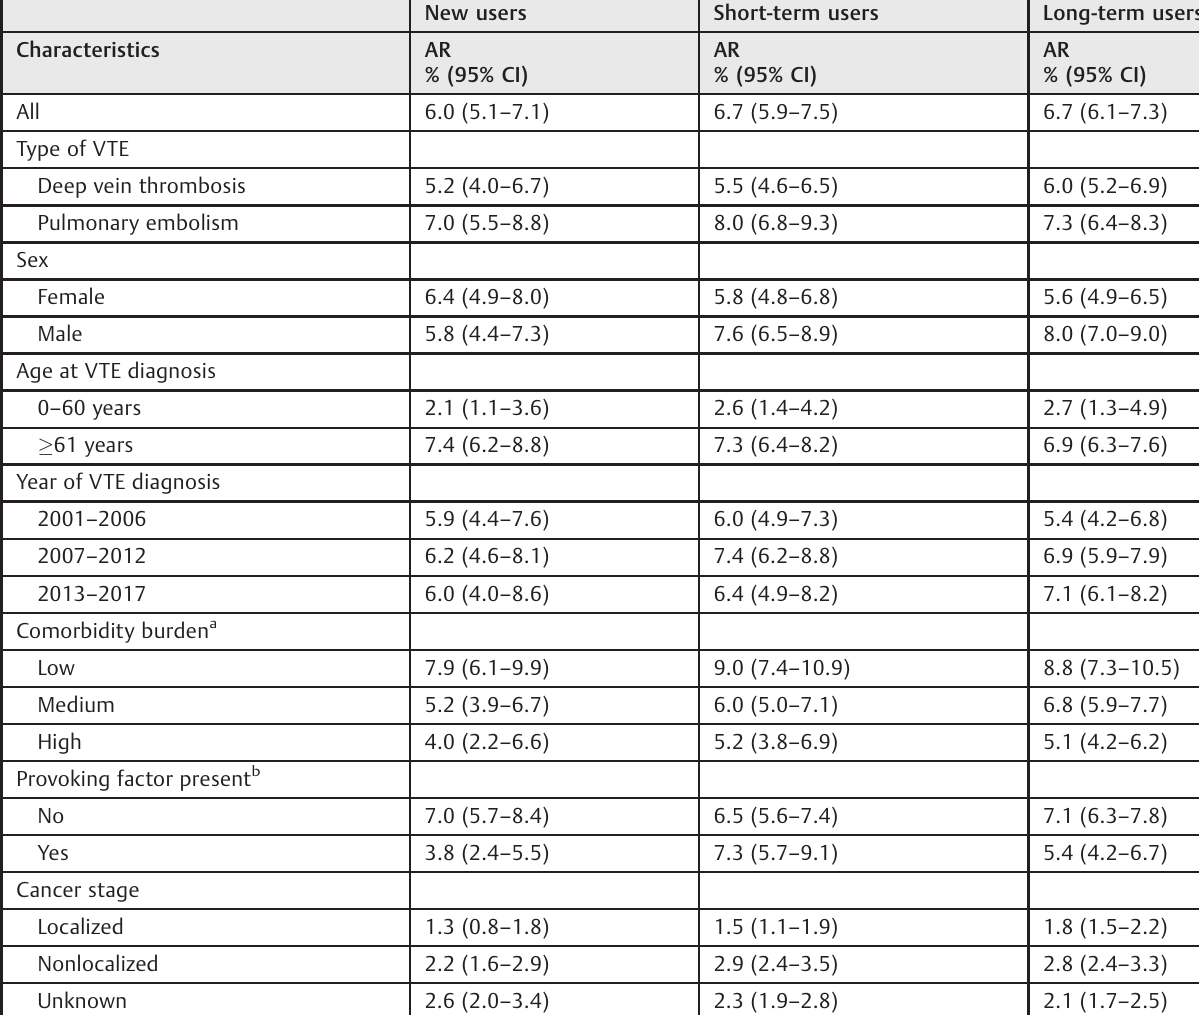
Table 2 Absolute risk of cancer in users of low-dose aspirin during the fi rst year subsequent to venous